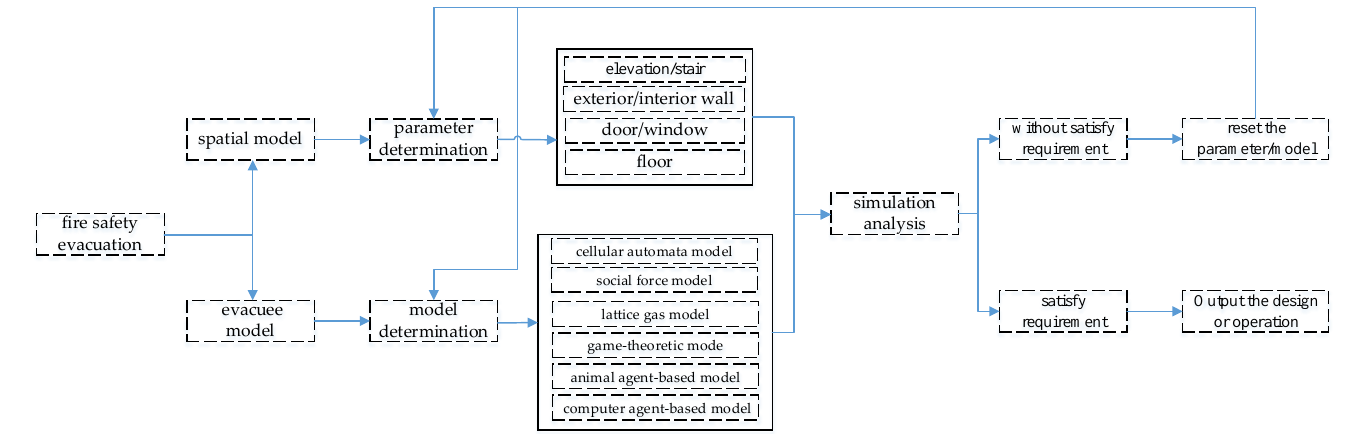
Figure 11. Research flow of fire safety evacuation.